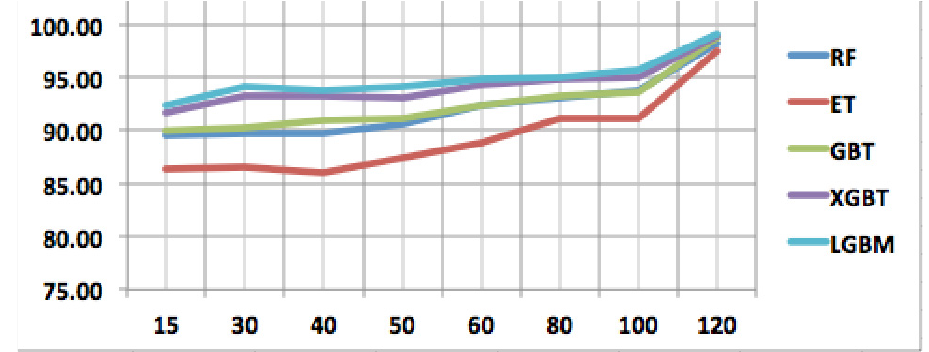
Figure 7. Performance sensitivity analysis of all models in cross-validation strategy.